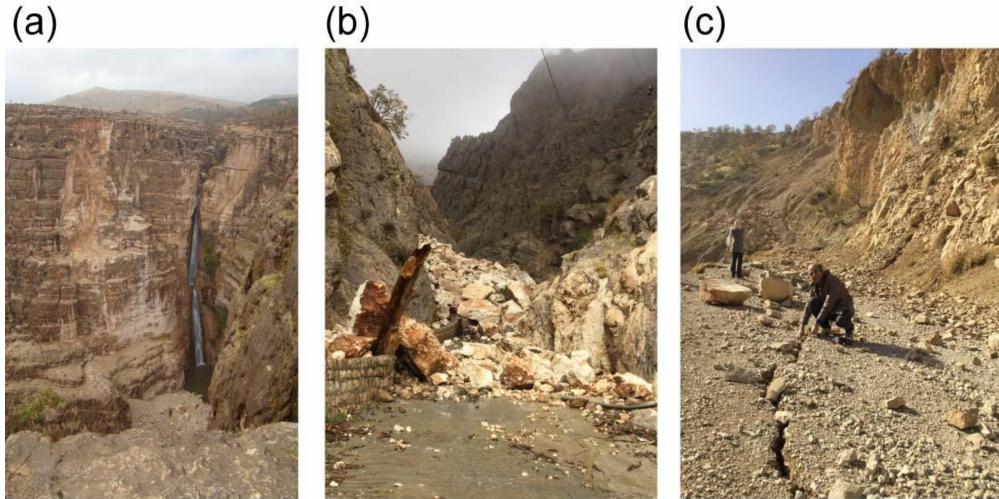
Figure 12. ( a ) A small-sized rockslide blocking Piran waterfall (P2 in Figure 9). ( b ) A big rockslide at the fault zone identified by P3 in Figure 9. ( c ) A large landslide that blocked the connecting road and caused a region of phase distortion in Figure 9a